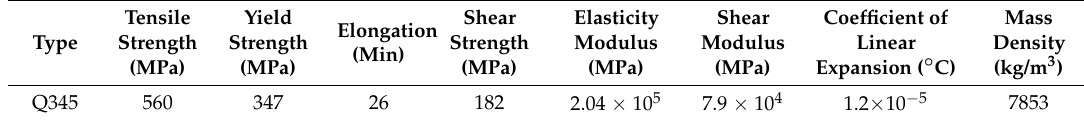
Table 5. Mechanical properties of steel